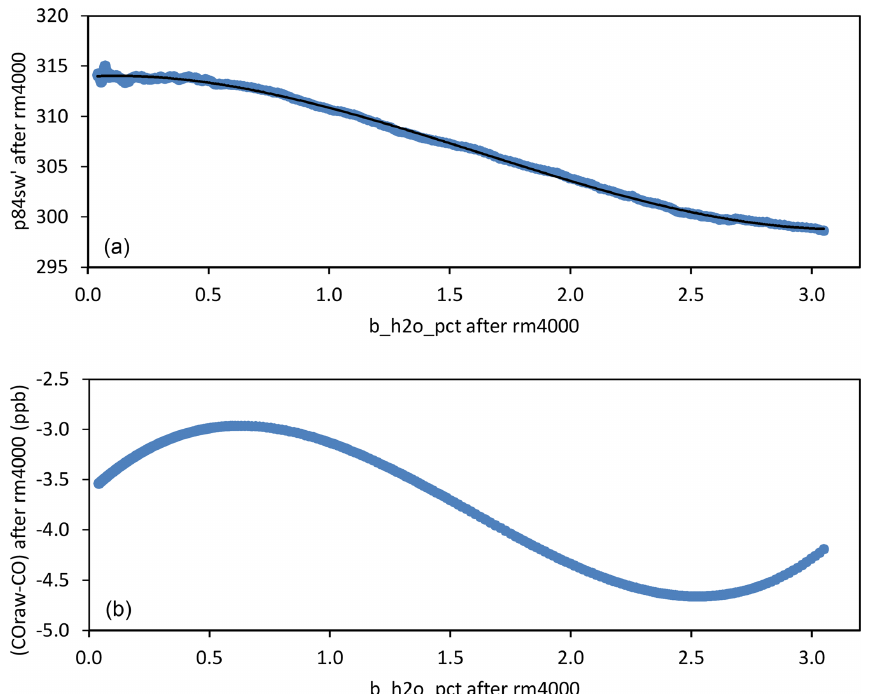
Figure 11. (a) p84sw’ vs. bh during the water-droplet experiment (blue dots), both after performing a 4000-data running mean, and the least-square fitted curve corresponding to Eq. (15) in black. (b) Difference between the raw CO provided by the CRDS and the CO processed in the way described in this article (including H 2 O correction and calibration), both after performing a 4000-data running